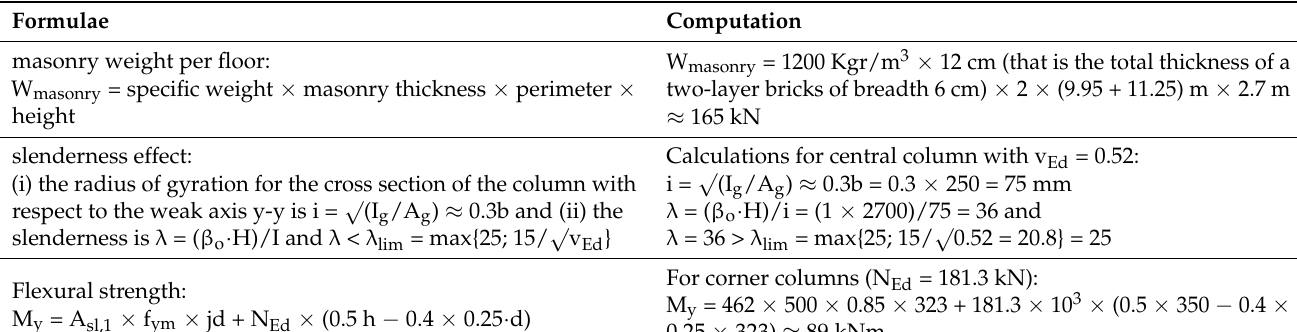
Table A1. Detailed computations of several assessment and retrofitting